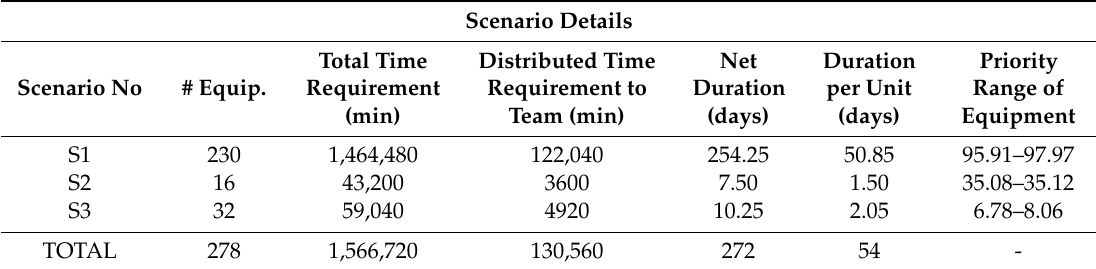
Table 9. Mechanical equipment revision maintenance planning scenario